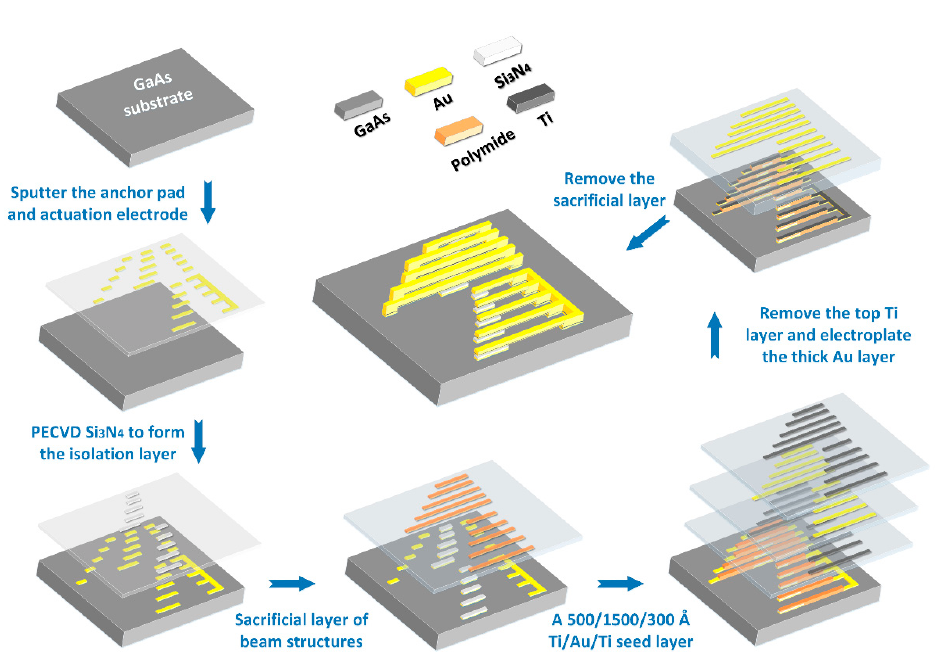
Figure 4. Topological SEM of GaAs MMIC-based MEMS beams: the left for bridge structures with the length ranging from 50 μm to 600 μm while the right for cantilevers with the length ranging from 50 μm to 380 μm . The spacing is 50 μm and 30 μm , respectively, for bridges and cantilevers. All the structures are 16 μm -width and 2 μm -thickness [36]. ( a ) ( b ) Figure 5. Statistical features of Young’s modulus: ( a ) PDF; the probability is over 70% while the horizontal axis ranges from 60 GPa to 105 GPa; ( b ) CDF; the intersection point takes a probability over 28% to evaluate Young’s modulus to 60 GPa.